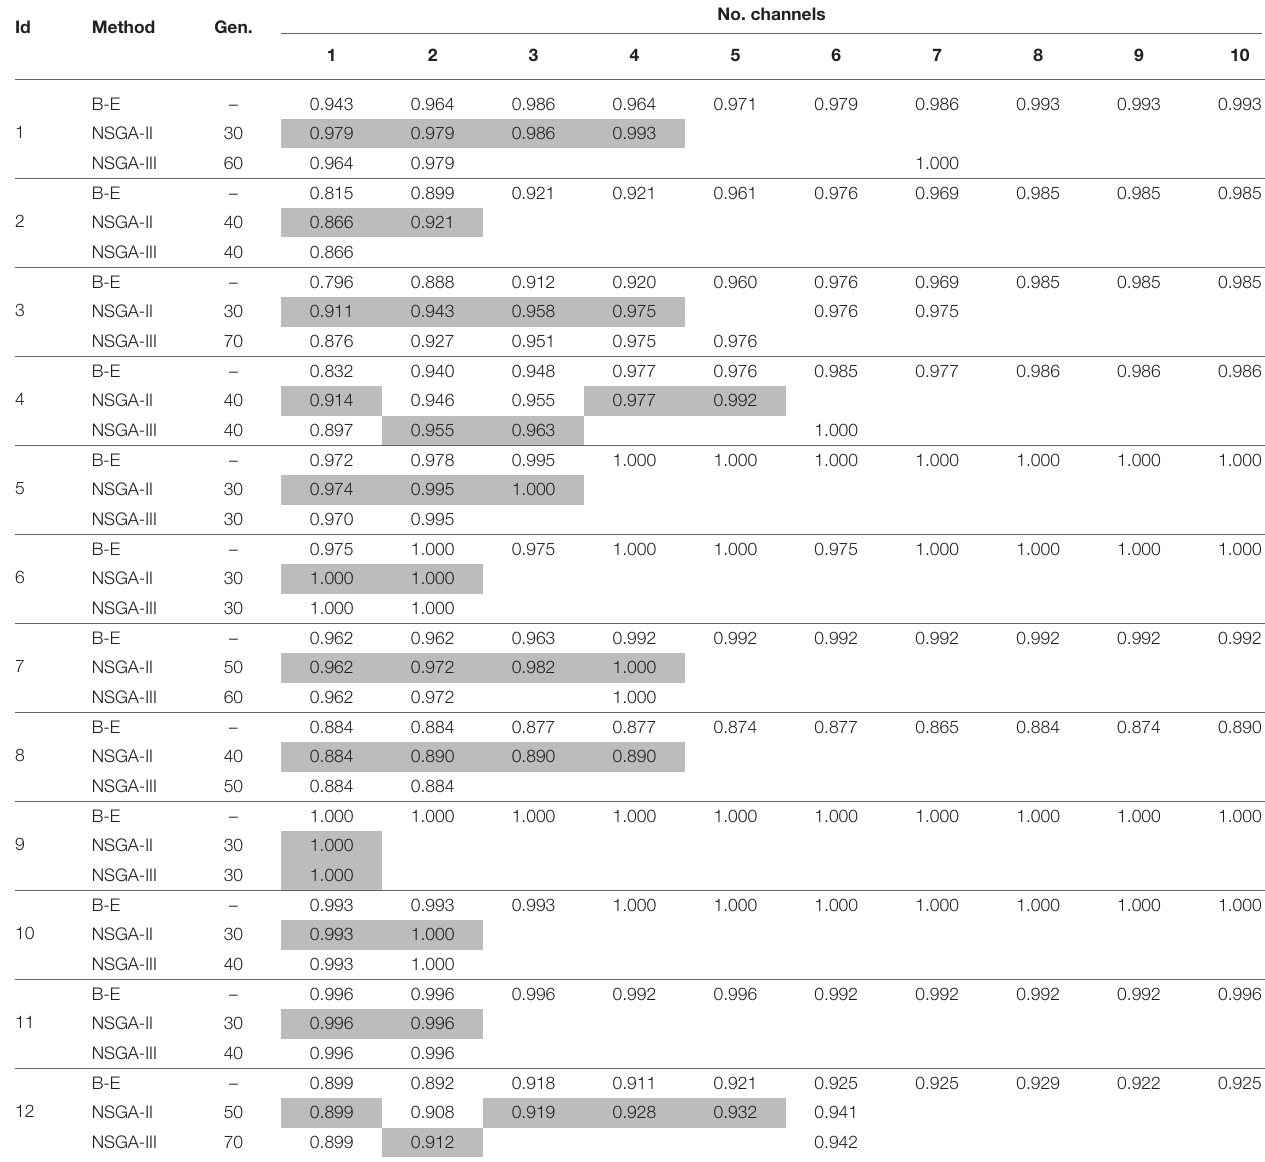
TABLE 1 | Accuracies obtained using EMD for feature extraction with NSGA-II and NSGA-III for EEG channel selection (Subjects 1–12).